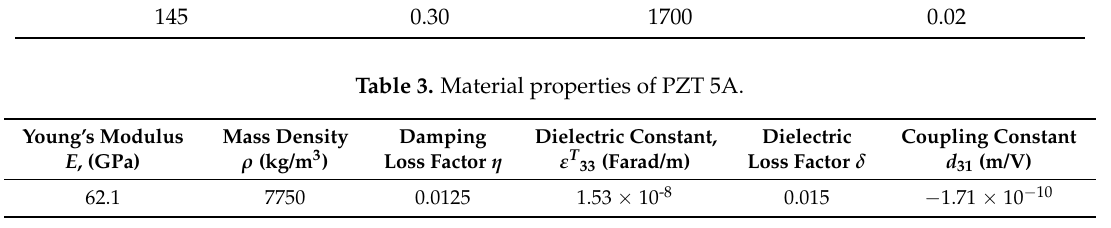
Table 3. Material properties of PZT 5A.